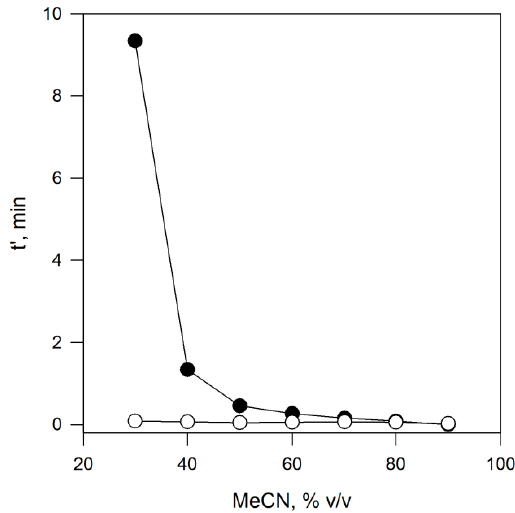
Figure 3. Reduced migration times ( t ′) measured in 2,4,5-T-imprinted (filled circles) and non-imprinted (empty circles) capillaries prepared with AICV initiator by using different percentages of acetonitrile added to 5 mmol∙L −1 phosphate buffer pH 2.0.